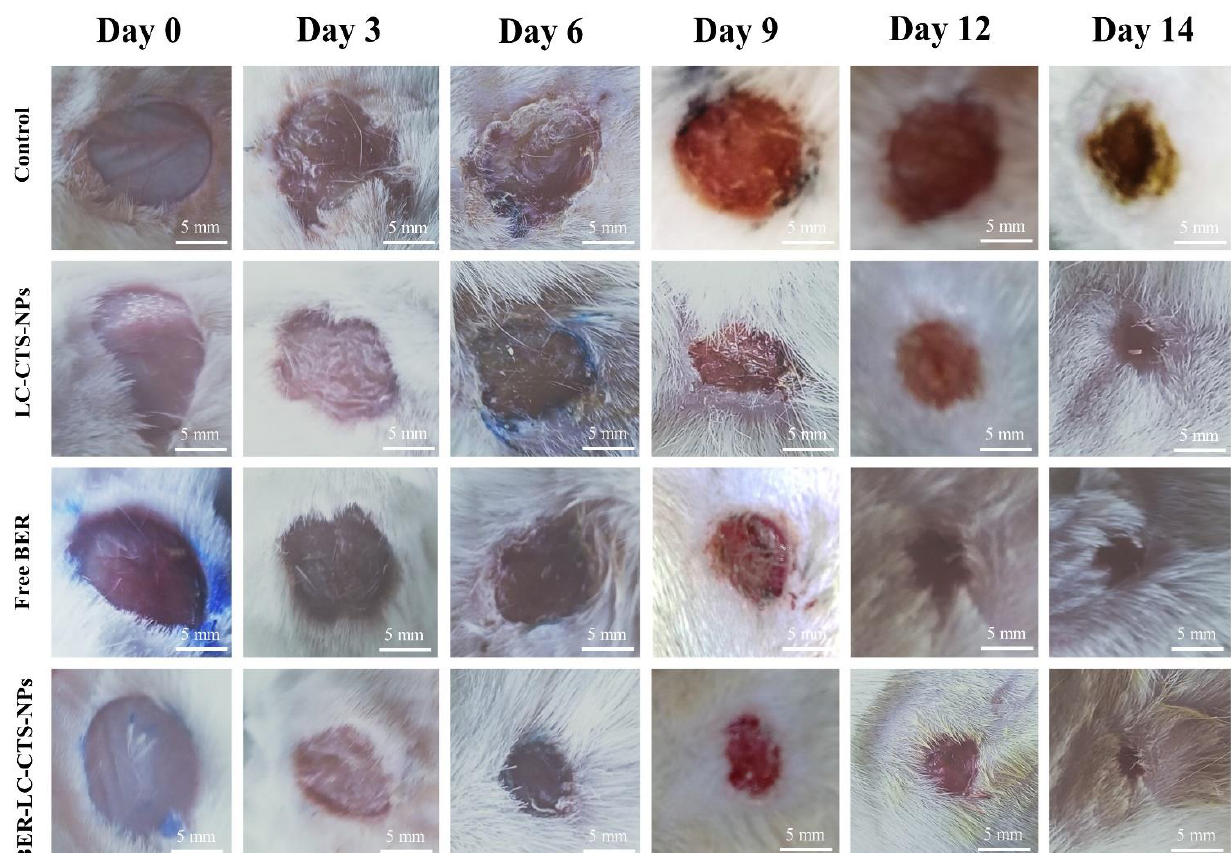
Figure 6. Photograph images of wound repair on the 0th, 3rd, 6th, 9th, 12th, and 14th day in the diabetic rats of the untreated (Control), lecithin–chitosan nanoparticles without berberine (LC-CTS-NPs), free berberine (Free BER), and lecithin–chitosan nanoparticles containing berberine (BER-LC-CTS-NPs) groups.